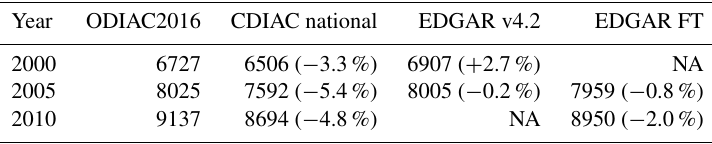
Table 1. Global total emissions estimates for 2000, 2005, and 2010 from four gridded emissions data estimates (ODIAC2016, CDIAC, EDGAR v4.2, and EDGAR FastTrack). Values for two versions of EDGAR emissions data were calculated by subtracting emissions from agriculture (IPCC code: 4C and 4D), land use change and forestry (5A, C, D, F, and 4E), and waste (6C) from the total EDGAR CO 2 emissions (total short cycle C).